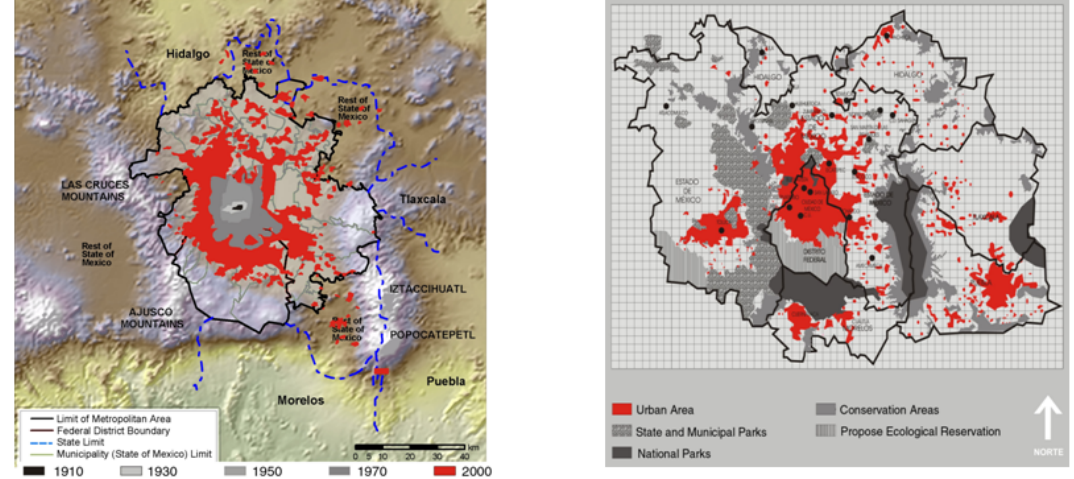
Fig. 1. Left Panel: topographical map of the MCMA; Right Panel: Megalopolis in the year 2000 (from Molina and Molina, 2002).